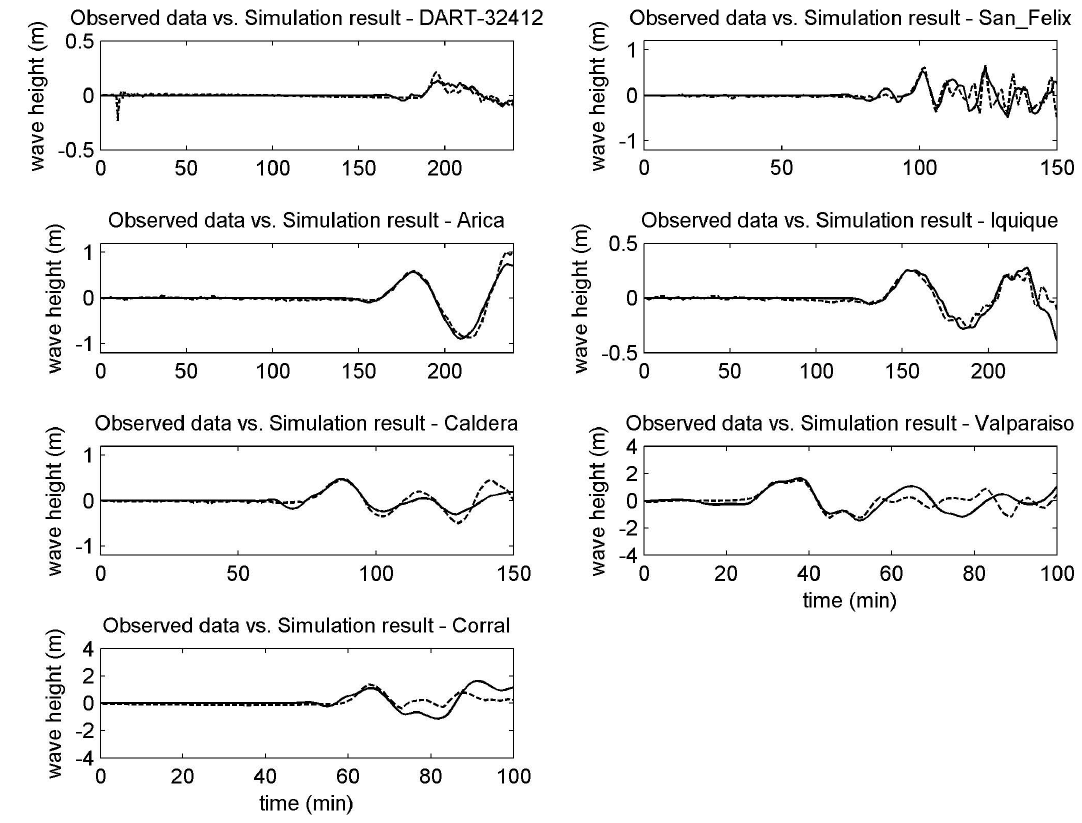
Fig. 10. Waveform comparisons. Solid lines: calculated waveforms with SUTIM. Dotted lines: field